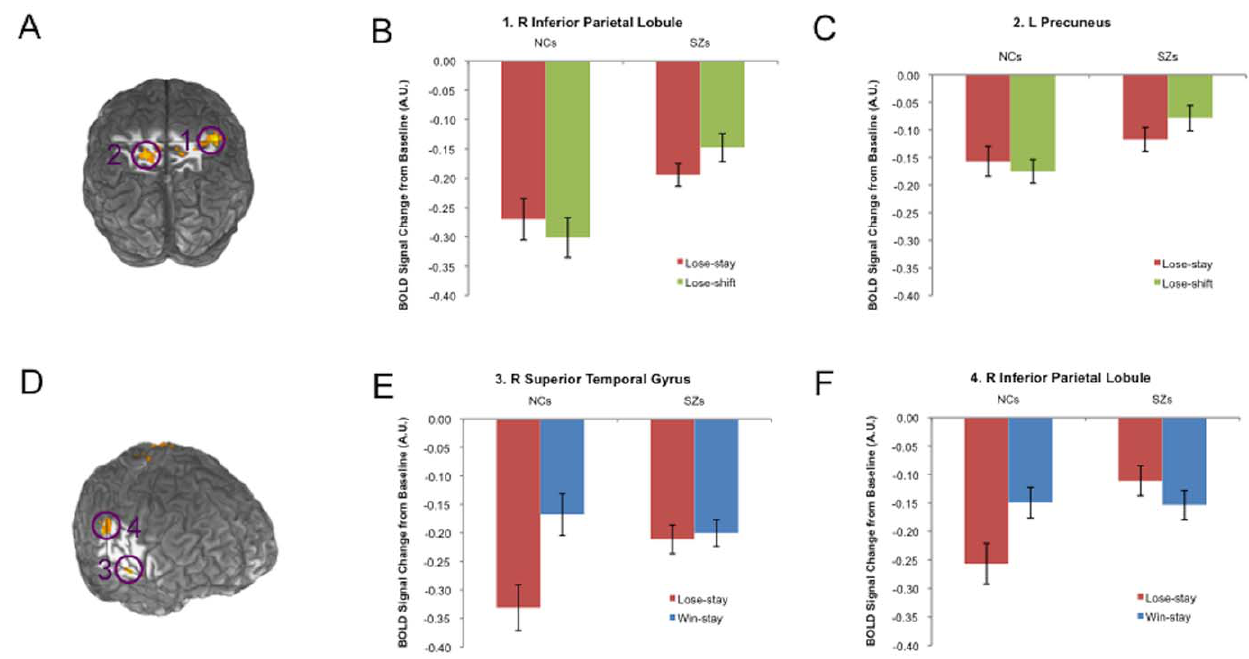
Figure 2. Brain regions showing group differences in condition contrasts (GROUP and CONDITION interactions). ( A ) Interacting effects of GROUP and CONDITION (lose-shift vs. win-stay) on responses were observed in R inferior parietal lobule and left precuneus (brain cuts at y= 2 33 and Z=56). In both ( B ) R inferior parietal lobule and ( C ) left precuneus, controls showed much stronger deactivations for lose-shifts (relative to win-stays) than patients did. ( D ) Interacting effects of GROUP and CONDITION (lose-stay vs. win-stay) on responses were observed in R lateral temporal cortex and R inferior parietal lobule (brain cuts at X=58, Y= 2 29, Z=0). In both ( E ) R lateral temporal cortex and ( F ) R inferior parietal lobule, controls showed much stronger deactivations for negative (relative to positive) feedback than patients did, when both forms of feedback led to stays.